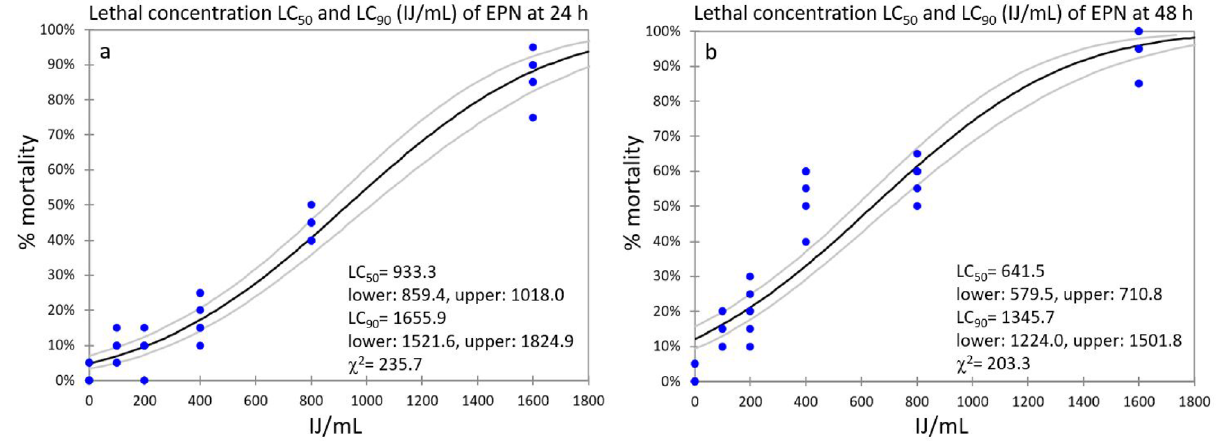
Figure 4. Sc lethal concentrations (LC 50 and LC 90 ), at 24 h ( a ) and 48 h ( b ), were calculated by Probit analysis with 95% confidence intervals.